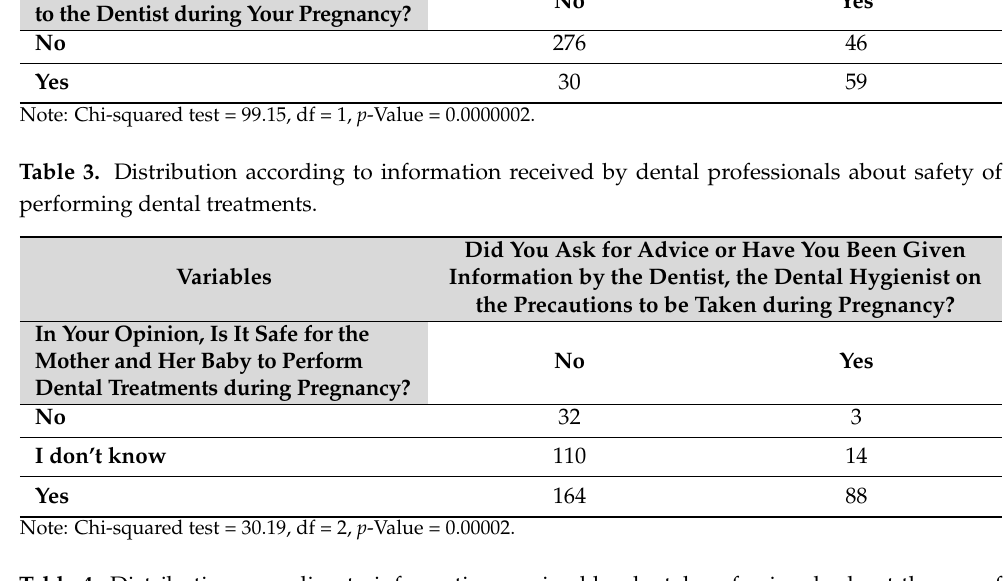
Table 4. Distribution according to information received by dental professionals about the age of starting cleaning the child’s